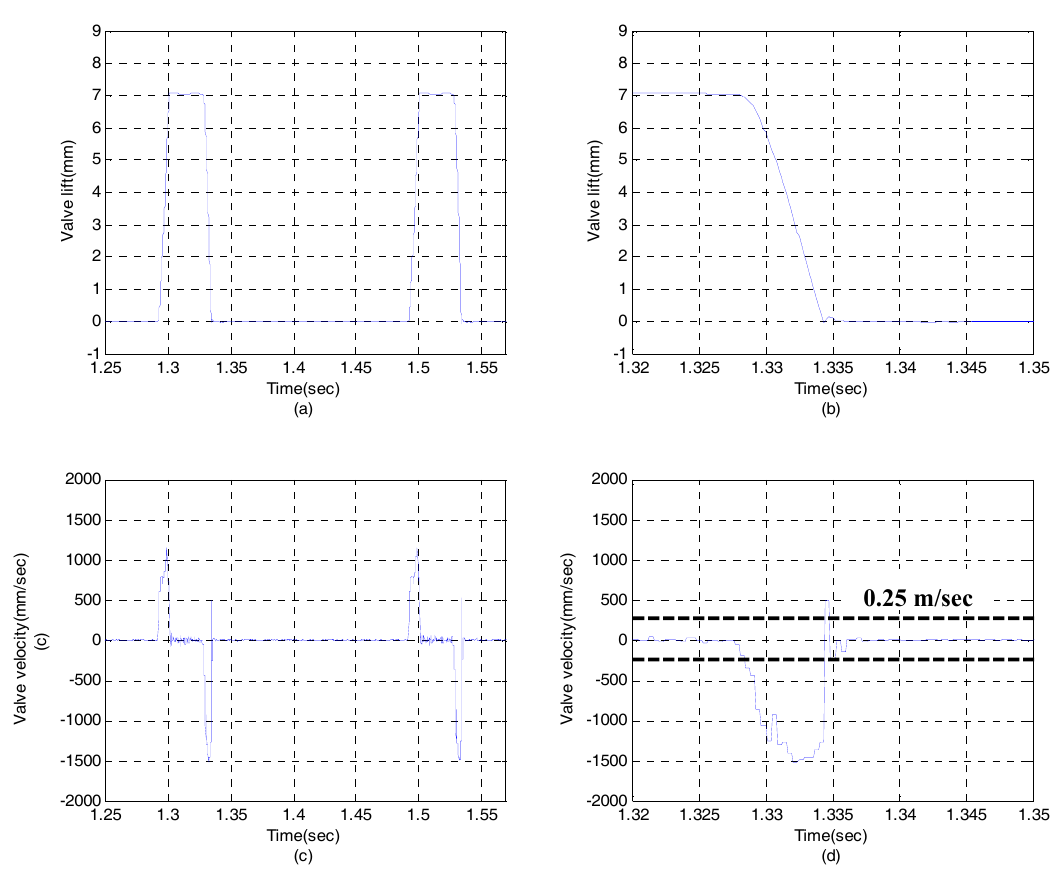
Figure 9. Experimental results for an EH-CEVA I with the 0.8 mm of snubber orifice: ( a ) valve lift profile, ( b ) zoomed in valve lift profile, ( c ) valve velocity profile, ( d ) zoomed-in valve velocity